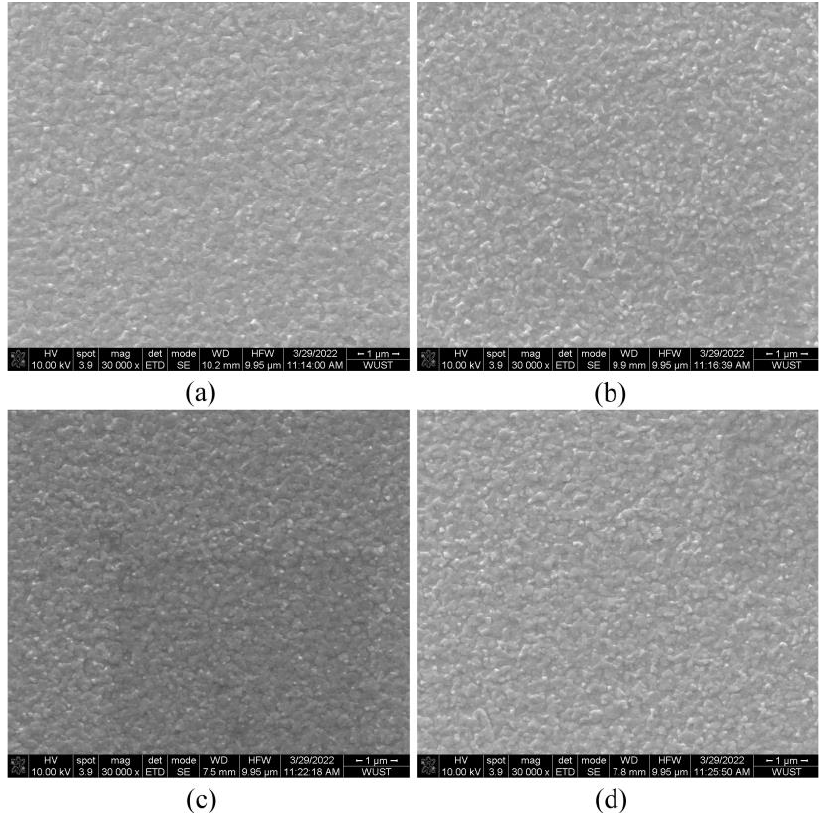
Figure 2. SEM images of perovskite films with ethyl acetate dropped at different times ( a ) without ethyl acetate ( b ) 10 s ( c ) 20 s ( d ) 30 s.